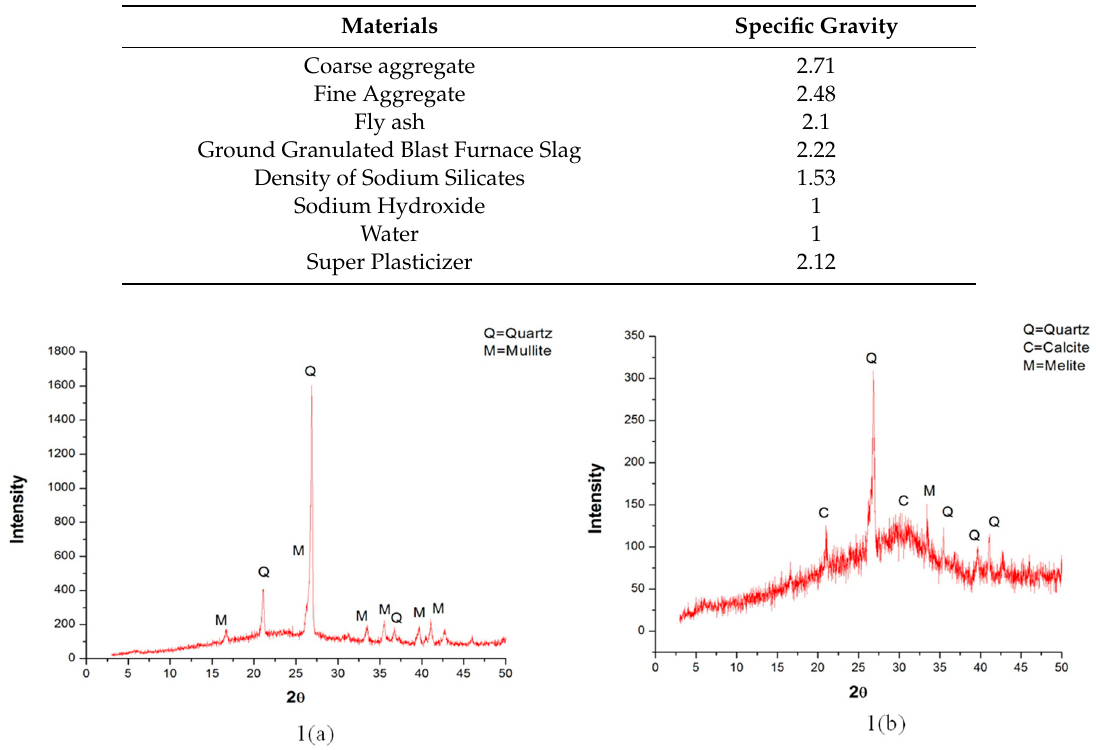
Figure 1. ( a ) X-ray diffraction (XRD) of flyash inorganic sample, ( b ) XRD of ground granulated blast furnace slag (GGBFS).